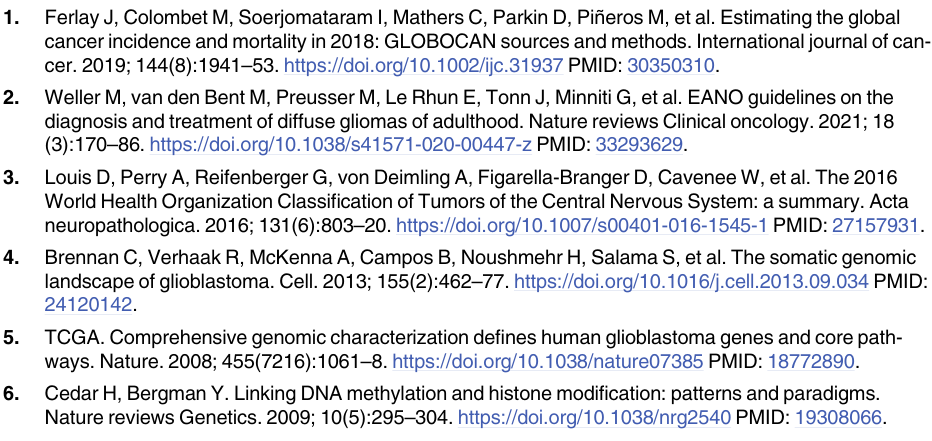
S4 Fig. Gene subtypes identification of characteristic genes based on RNA modification. (TIF) S5 Fig. Differences of PCA_score in different clinical traits. (TIF) S6 Fig. PCA analysis and ROC curve analysis. (TIF) S7 Fig. Validation of the PCA_score prognostic model of the TCGA-LGG cohort. (TIF) S8 Fig. Correlation between PCA_score and IC50 of common Chemotherapy drugs. (TIF) S9 Fig. Kaplan–Meier survival curve of Radio group and non-Chemo group in H-PCA_- score.